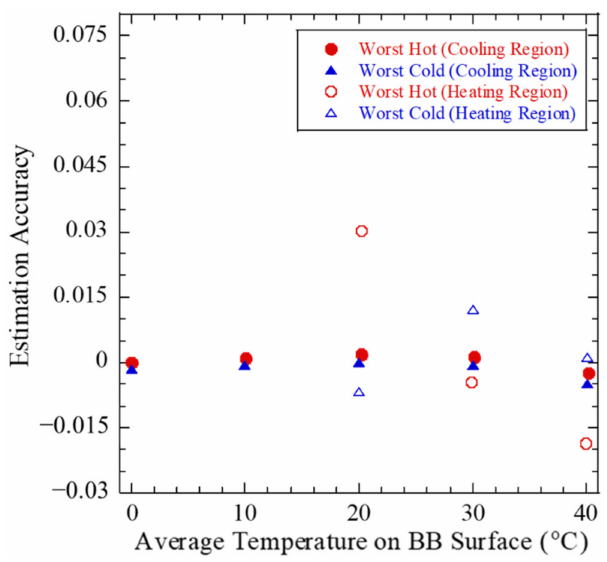
Figure 12. Estimation accuracy of